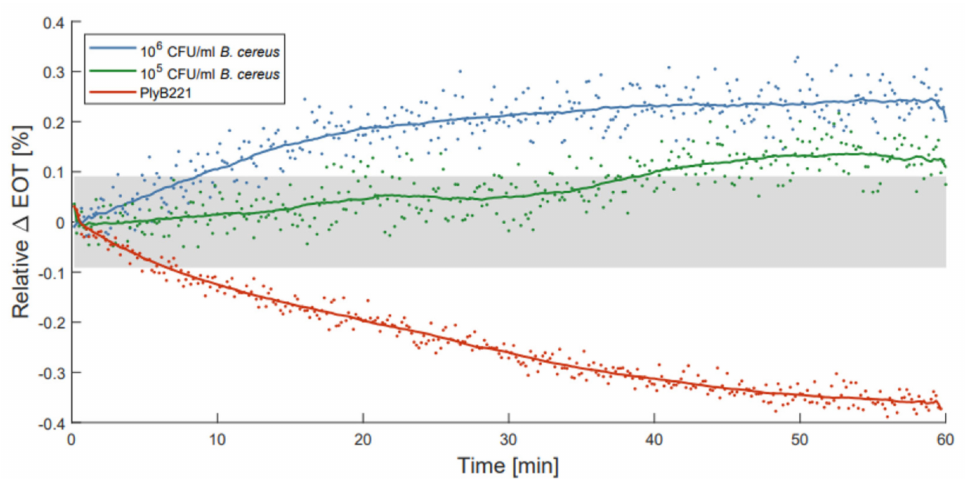
Figure 9. Relative effective optical thickness (EOT) shift measured on a PSi membrane for 1 h in in PlyB221 endolysin suspension (red), and in a B. cereus lysate at 10 6 CFU/mL (blue) and at 10 5 CFU/mL (green)